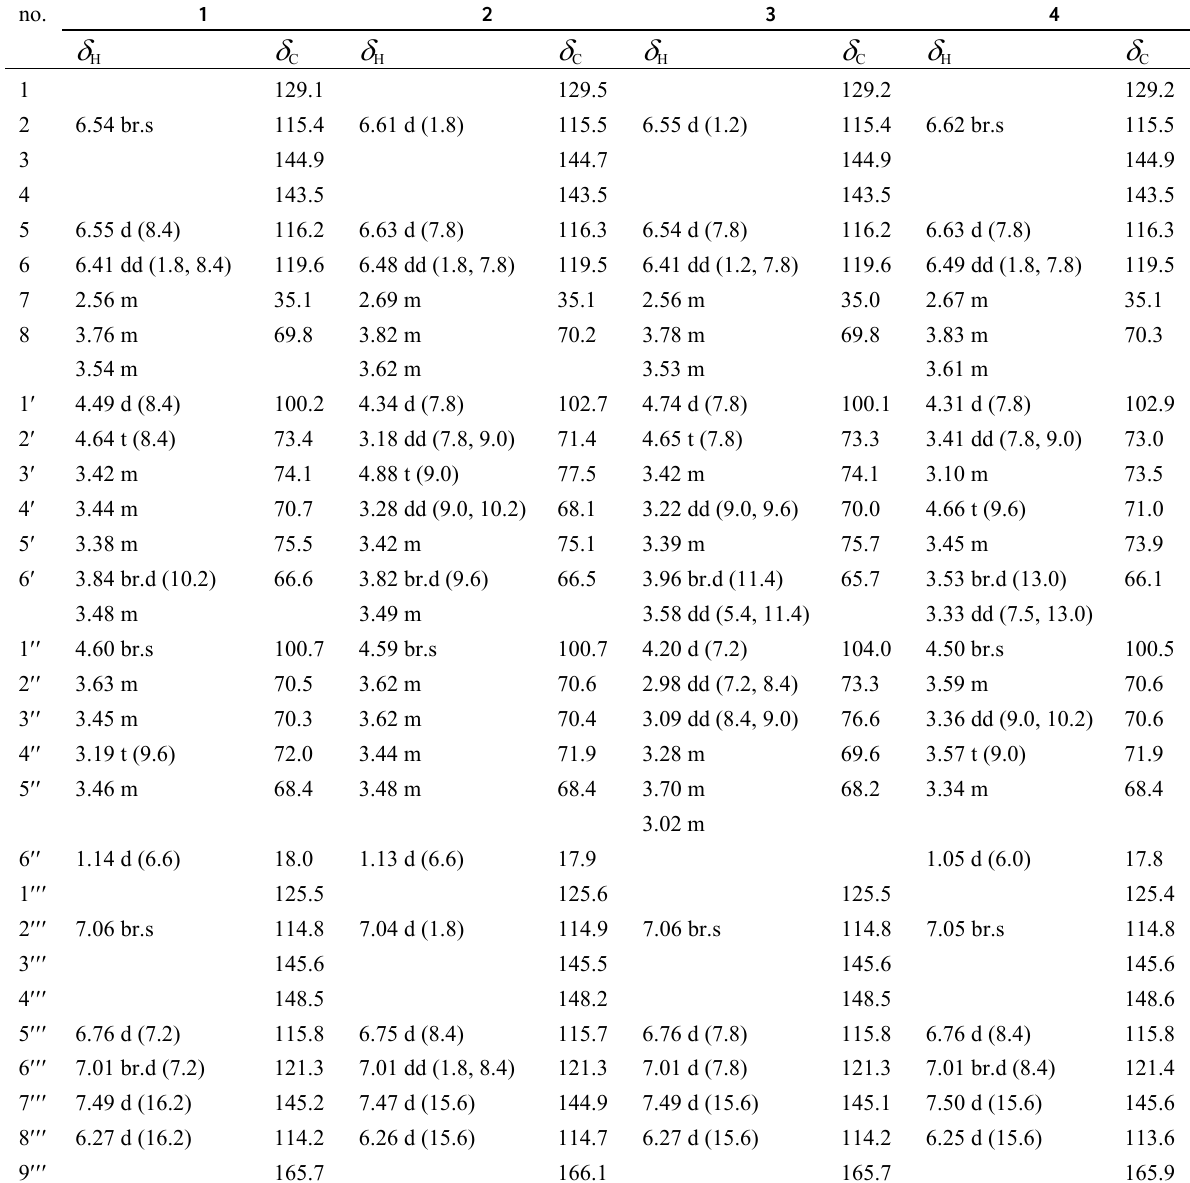
Table 1. NMR Data for Compounds 1 - 4 a